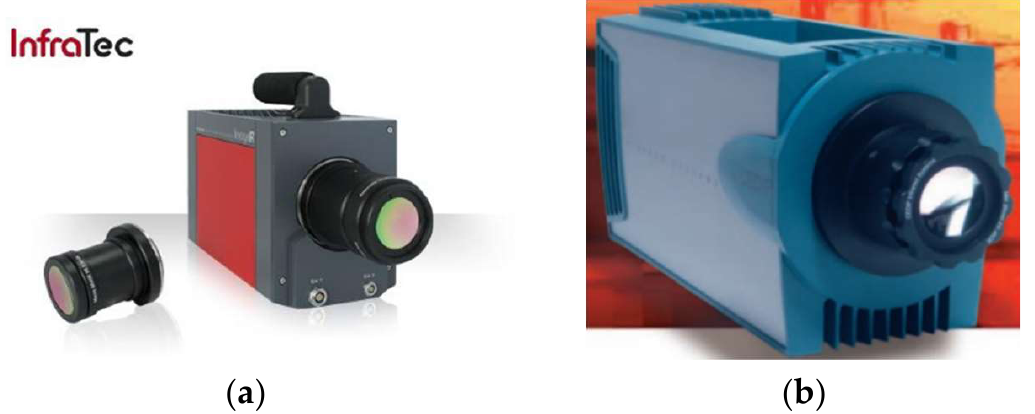
Figure 11. Experimental mid-wave IR thermal imaging system. ( a ) Cooled mid-wave thermal imaging camera ImageIR 8355; ( b ) cooled mid-wave thermal imaging camera Jade.